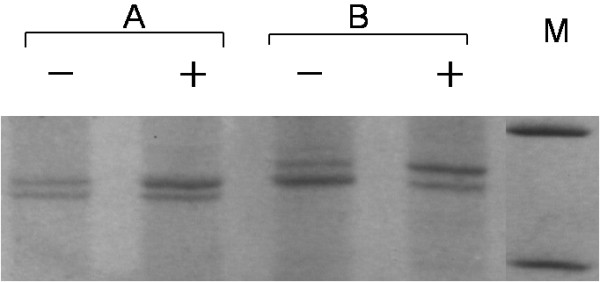
Representative data of AR gene exon 1 amplification products of two subjects (A and B) with CAG STR polymorphism. +, with HpaII digestion; -, without HpaII digestion; M, DNA marker, the upper and lower bands representing positions of 300 and 200 bp, respectively.